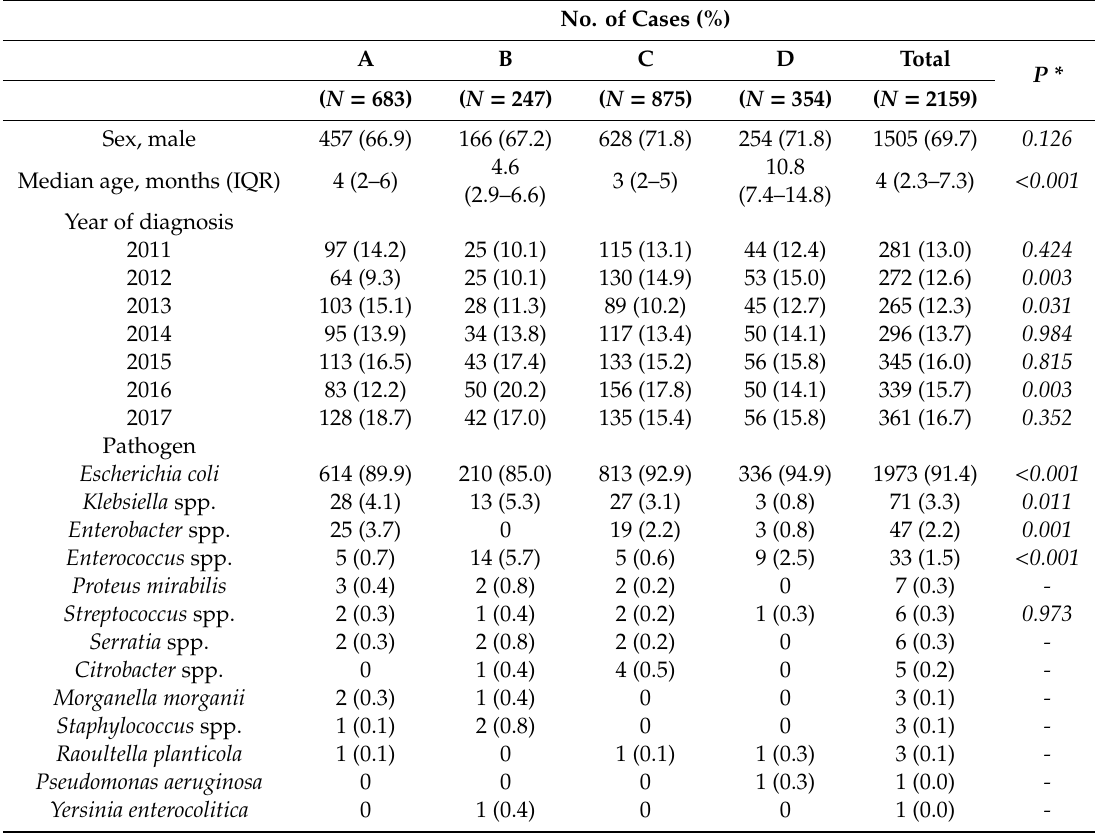
Figure 1. Flow chart of the patients included in this study. A total of 2159 patients below 24 months old were included in the study. Table 1. Demographics of the patients included in this study, the year diagnosed, and uropathogens cultured at each of the